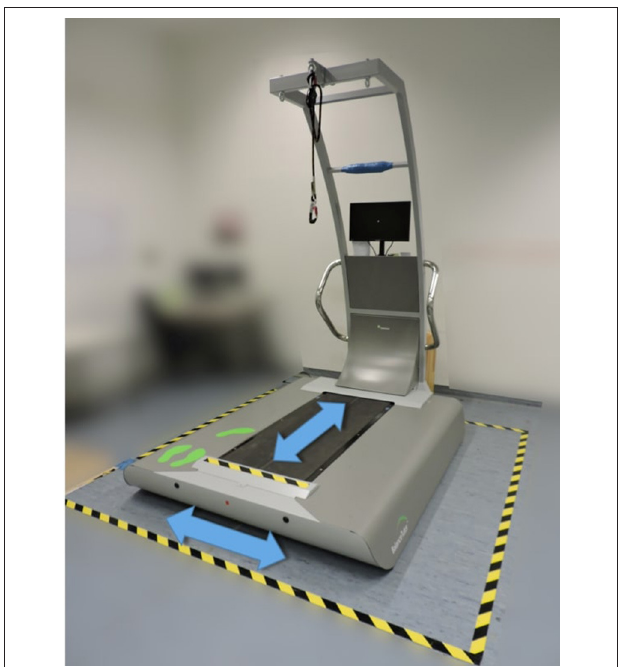
FIGURE 2 | Balance tutor and directions of surface translation.